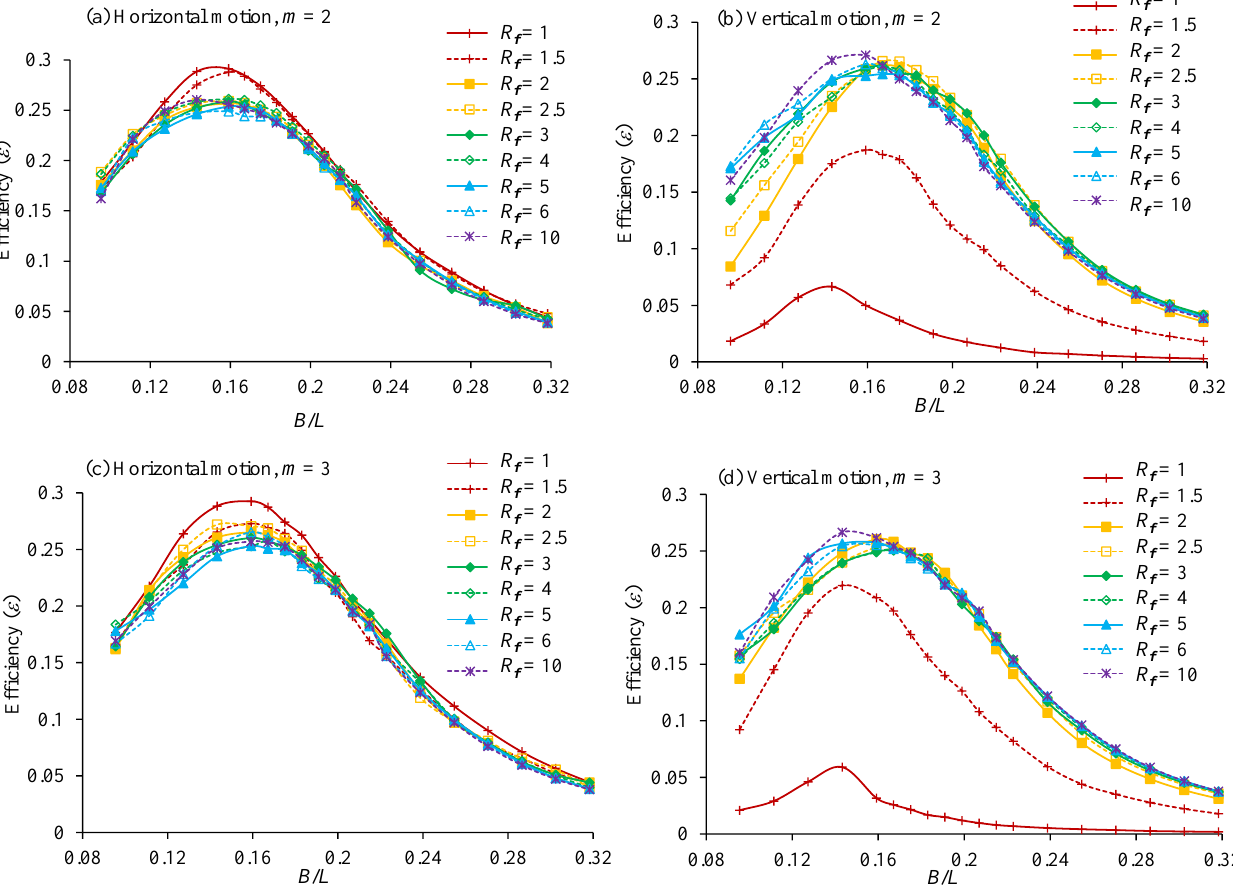
Figure 3. Variation of the floating OWC device efficiency ε with B / L under nine different frequency ratios ( R f ) at d / h = 0.25, K t = 3000 Pa · m − 3 ·